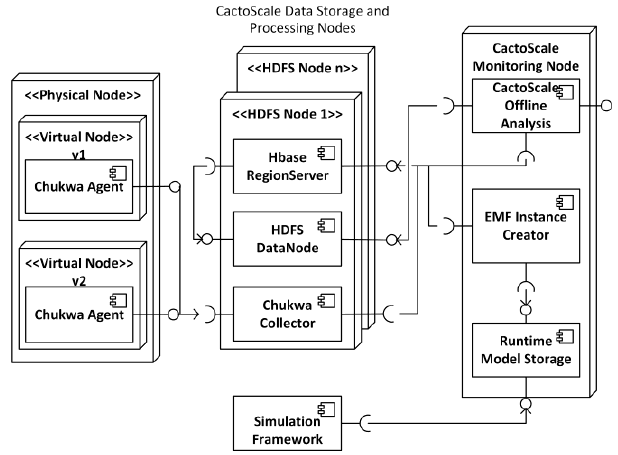
Figure 3. CactoScale